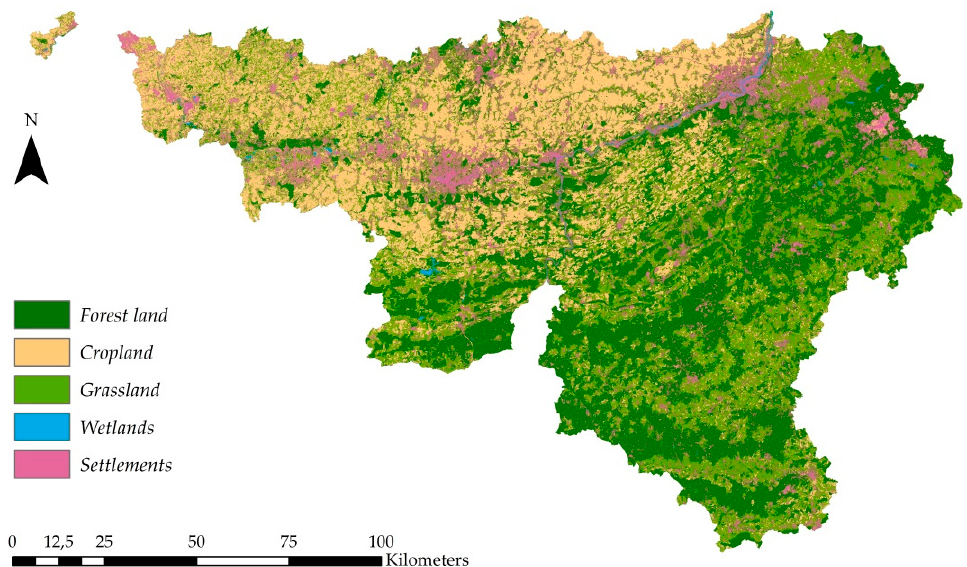
Figure 7. Winter-spring-summer classification with four bands (B2, B3, B4, B8a) of Wallonia, Belgium. This classification was produced with Sentinel-2 data from the three-season mosaics (winter, spring, and summer 2016). The maximum likelihood classification algorithm was used with a training dataset of 372 samples (30% of the dataset). This classification reached an OA of 92.6%.